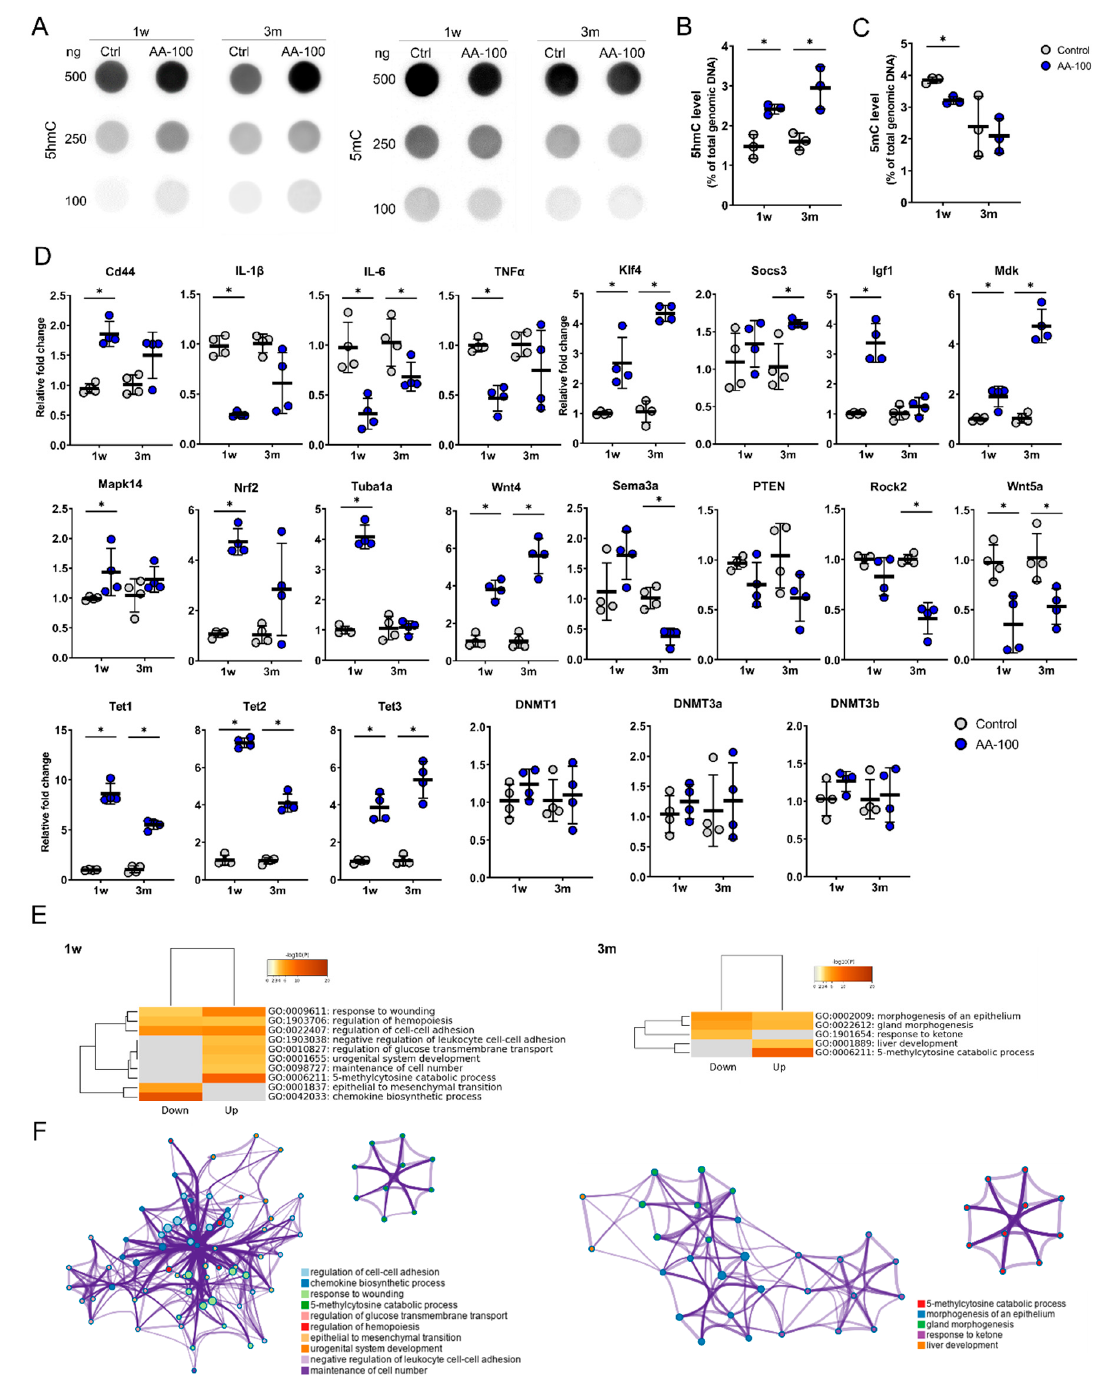
Figure 6. Dot blot and real-time PCR results for the primary motor cortexes of rats in the control and AA-100 groups at 1 week (1 w) and 3 months (3 m) after injury. ( A ) Representative results for 100, 250, and 500 ng of 5hmC and 5mC in the control and AA-100 groups 1 w and 3 m after injury. ( B , C ) Quantitative data from dot blot analysis of 250 ng of 5hmC ( B ) and 5mC ( C ) levels compared with the amount in total genomic DNA (%) in the control and AA-100 groups ( n = 3 per group); * p < 0.05